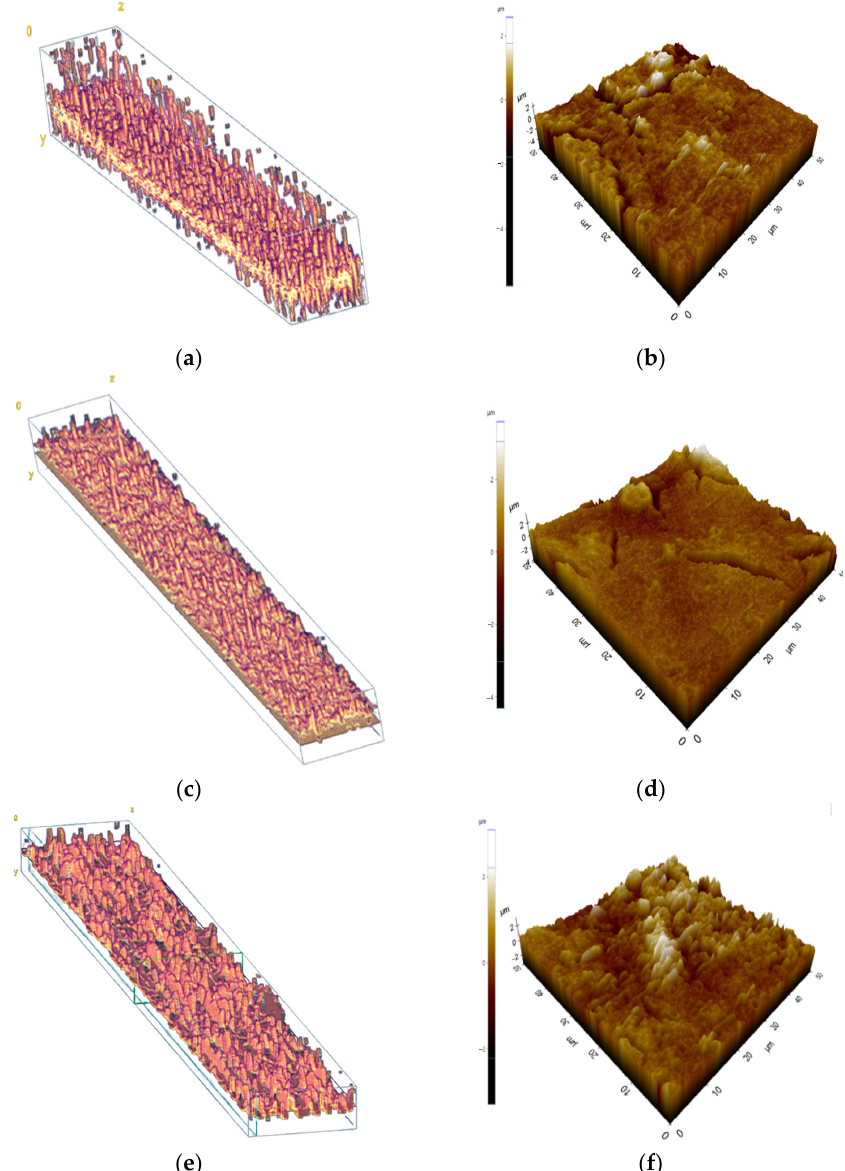
Figure 13. In OCT images ( a , c , e ), the yellow color represents the membrane, while the pink color above the yellow corresponds to the foulant layer on top of the membrane. In AFM images ( b , d , f ), brighter colors indicate that the foulant layers are stacked higher on the membrane compared to other areas ( a ) 3D OCT image for continuous RO operation (Case 1), ( b ) AFM image for continuous RO operation (Case 1), ( c ) 3D OCT image for RO operation with membrane storage in the feed water (Case 2), ( d ) AFM image for RO operation with membrane storage in the feed water (Case 2), ( e ) 3D OCT image for RO operation with the membrane storage in DI water (Case 3), and ( f ) AFM image for RO operation with the membrane storage in DI water (Case 3).